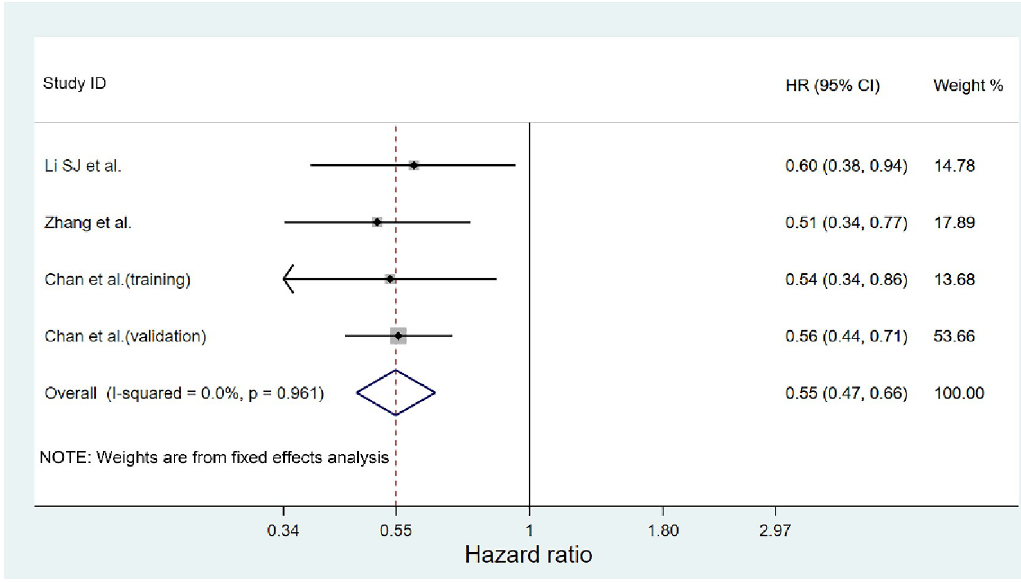
Fig 3. Forest plot of hazard ratio for DFS in cancer patients.